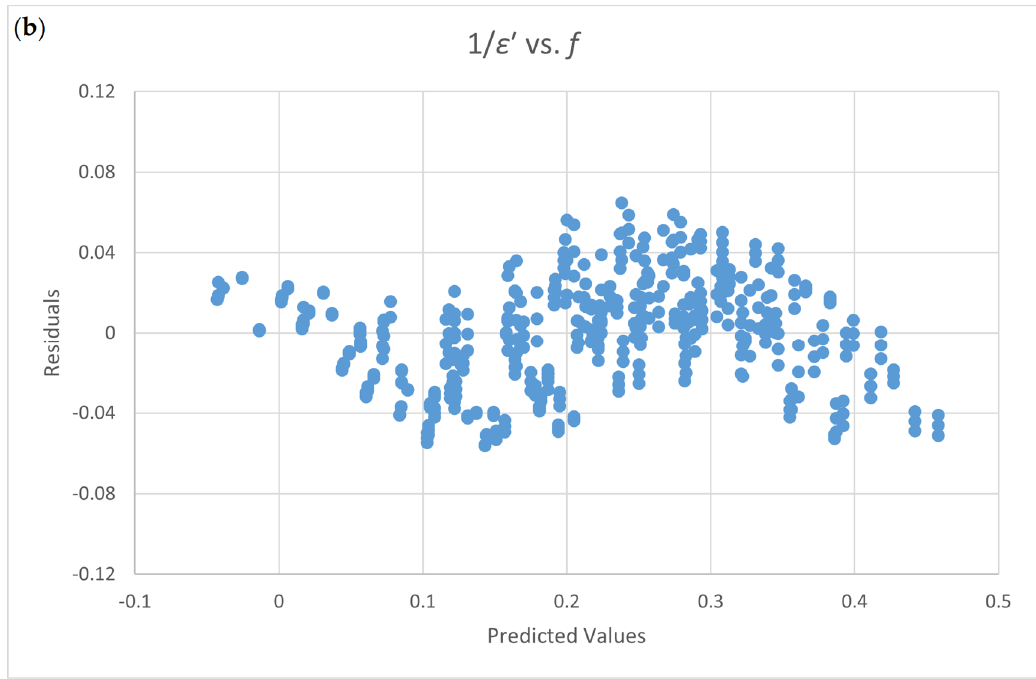
Figure 4. Residual plots for the dielectric constant ε’ equation for chicken flour (Guo et al. data [11]); ( a ). ε ′ vs. (cid:1858) ; ( b ). 1/ ε ′ vs. f. Only the equation, ln((cid:2013) (cid:4593)(cid:4593) ) vs. g((cid:1850), (cid:1846), ln (cid:1858)) , is an appropriate model. These variables have a more complex form, e.g., T 3 , ( T × ln f ) 2 and ( T × X ) 2 . The residual plots for ε″ vs. ln (cid:1858) are shown in Figure 5a. The funnel effect shows a heterogeneous variance. In Figure 5b, the ln(cid:2013) (cid:4593)(cid:4593) vs. ln (cid:1858) model has a uniform distribution for residual data.